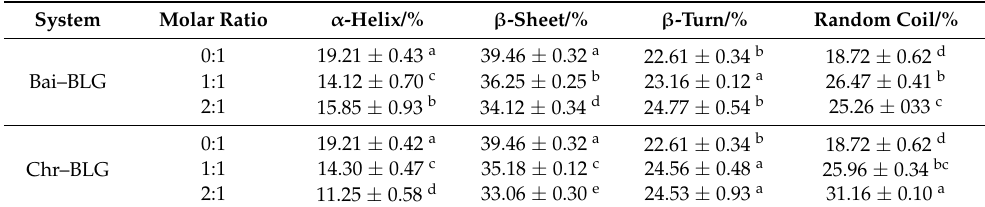
Figure 3. Far–UV CD spectra of BLG with increasing concentrations of Bai ( A ) and Chr ( B ), the molar ratios of Bai/Chr to BLG were 0:1, 1:1 and 2:1. ( C ) Effect of different concentrations of Bai/Chr on sulfhydryl group (SH) contents of BLG. Table 2. Secondary structure contents of Bai–BLG and Chr–BLG systems at different molar ratios of Bai/Chr to BLG.